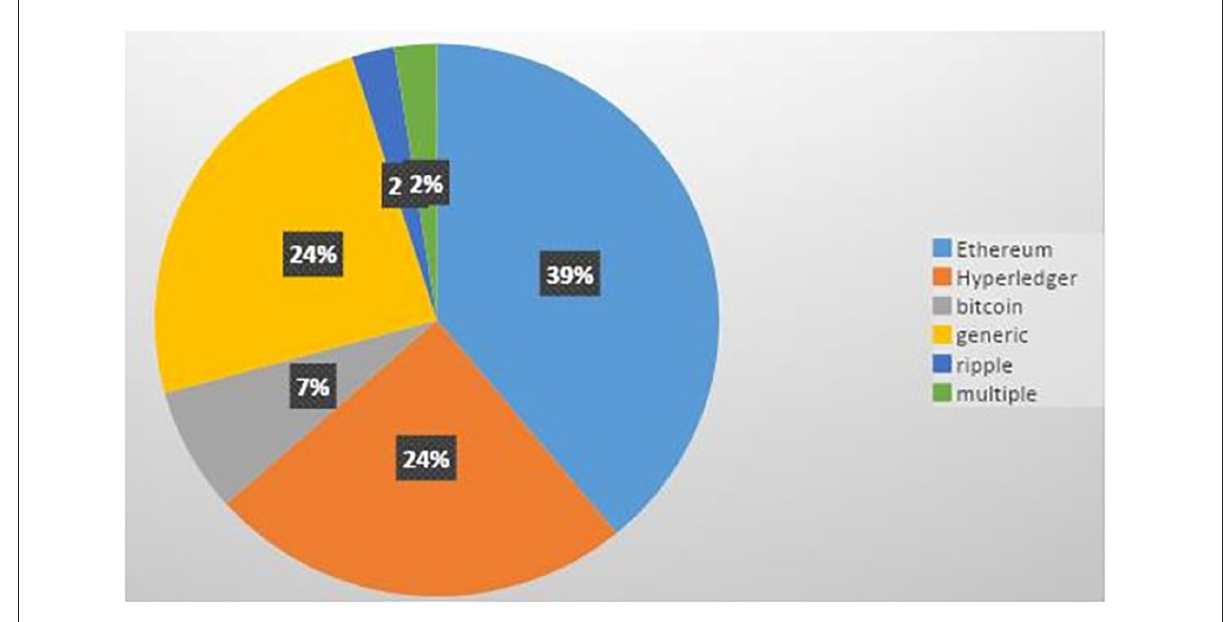
FIGURE3 Blockchain platform used for access control solutions in